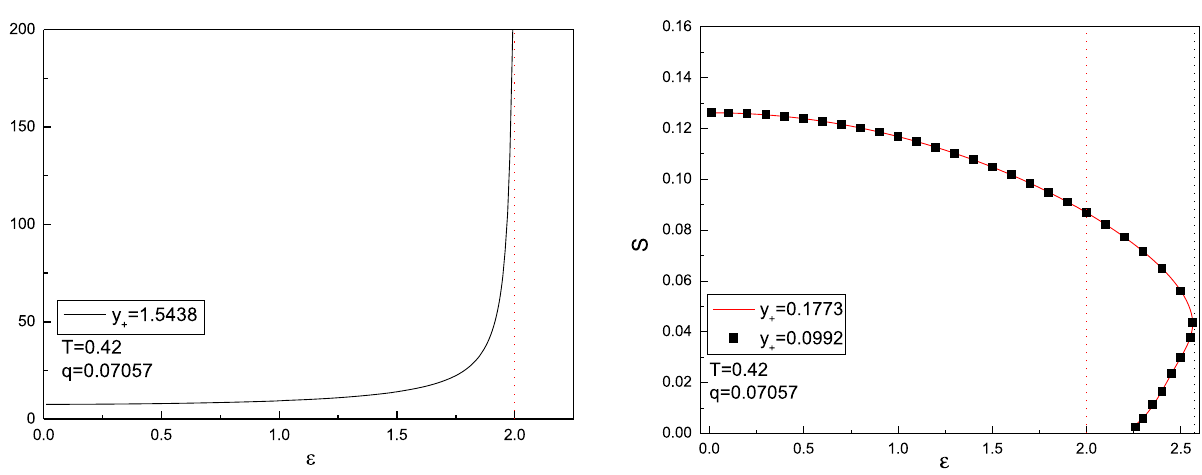
parameter ε for two small branches of black hole y + = 0 . 1773 (red line) and y + = 0 . 0992 (black dots). The vertical red and black dot lines represent ε = 2 and ε = 2 . 57 respectively